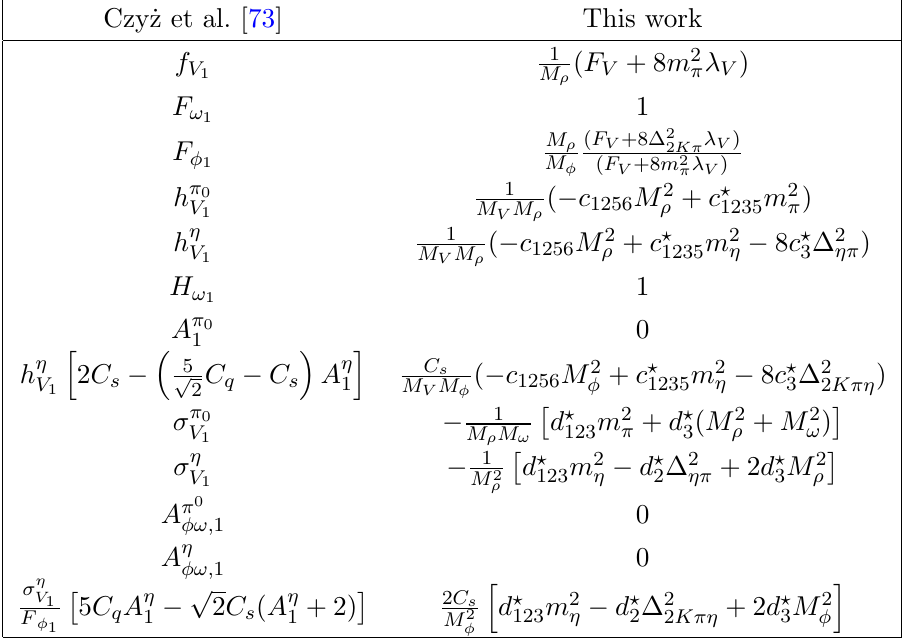
Table 10 . Relations between the parameters in the model of ref. [73] and this work. The expressions have been derived comparing various on-shell vertices, as explained in the text. The relations for (cid:17) 0 are again obtained from the (cid:17) ones as explained after eq. (3.8). in the 1 =N C expansion (barring those in the (cid:17) (cid:0) (cid:17) 0 mixing). This derives from the